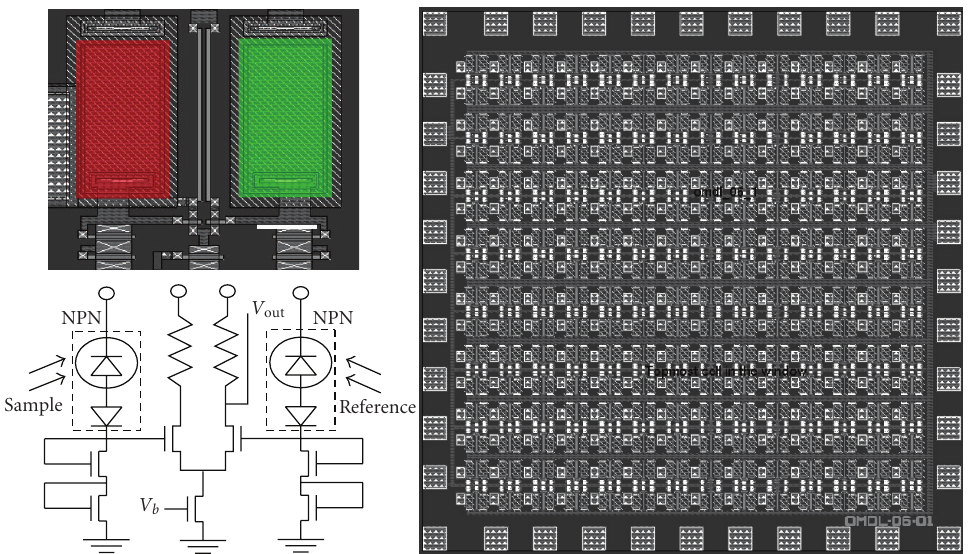
Figure 2: (right) Proposed layout of a 15-by-15 unit cell array of the di ff erential logarithm circuitry (2.2mm by 2.2 mm), (top left) an enlarged view of the layout of a single cell with pseudo thin-film monochromatic filter layers, and (bottom left) the schematic diagram of a single unit cell.